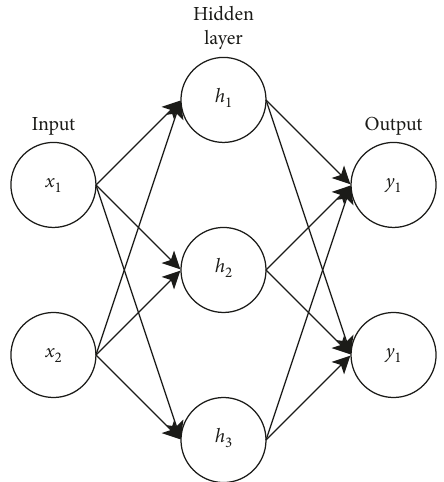
Figure 1: Feedforward neural network with 3 hidden units and 2 output